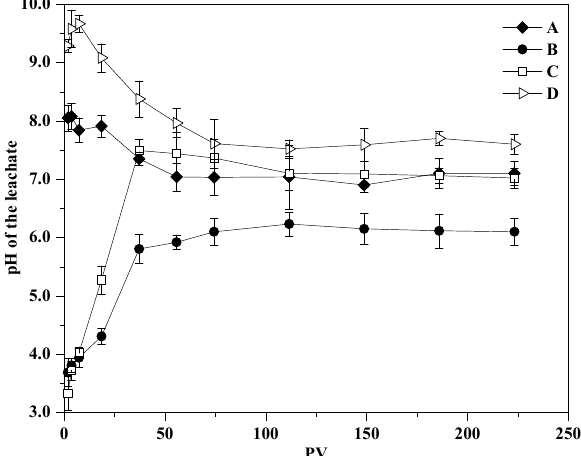
Figure 6. Leach solution pH with change in PV.